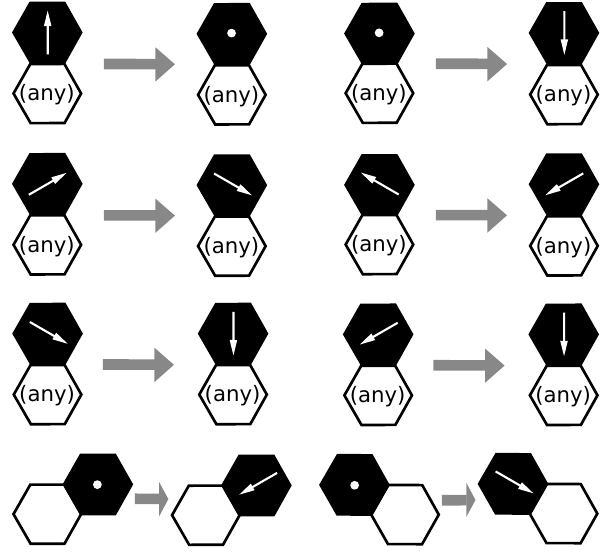
Figure 14. Gravity rules for lattice-grain model. Each transition has a rate g . The bottom two transitions represent angle-of-repose be- havior. This example uses the OrientedHexCTS